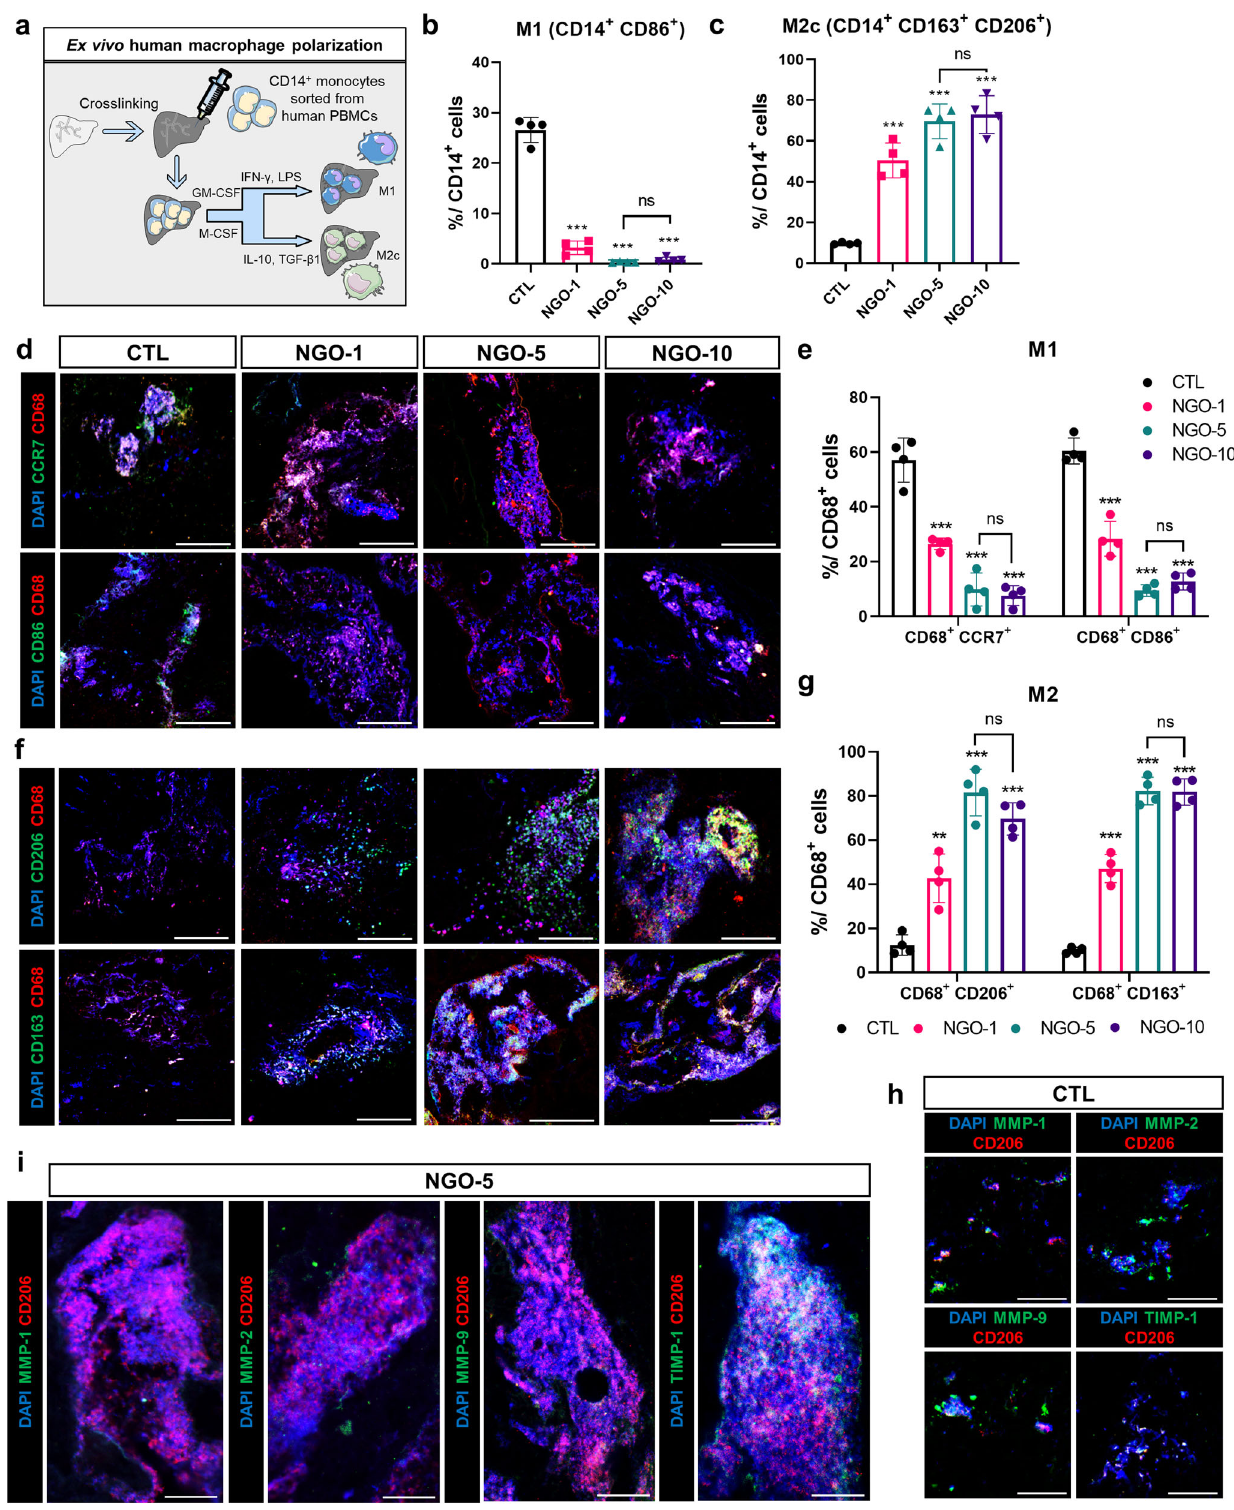
Fig.5|ExvivomacrophagepolarizationfromhPBMCswithinNGO-crosslinked scaffolds.a Schematicdiagramofexvivomacrophagedifferentiationfromhuman CD14 + monocytes within scaffolds crosslinked with nano-graphene oxide (NGO). FlowcytometryanalysisofM1 (b) andM2c (c) expressionwithinCD14 + populations ineachgroup ( n =4). d Representative confocalimages of M1 (CCR7, CD86:green, CD68: red, DAPI: blue). Scale bar, 100 µ m. e Quanti fi cation of M1 normalized to CD68 + cells ( n =4). f Representative confocal images of M2 (CD206, CD163: green, CD68: red, DAPI: blue). Scale bar, 100 µ m. g Quanti fi cation of M2 normalized to